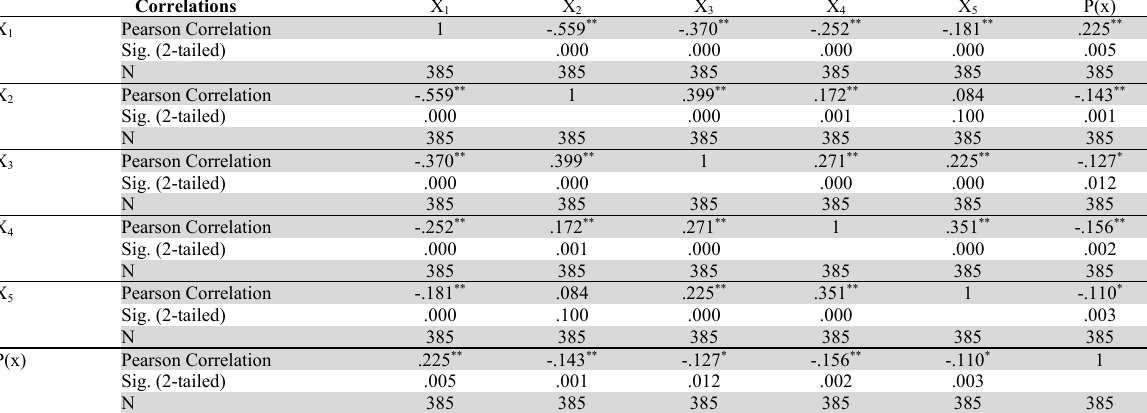
The correlative matrix between variables Correlations